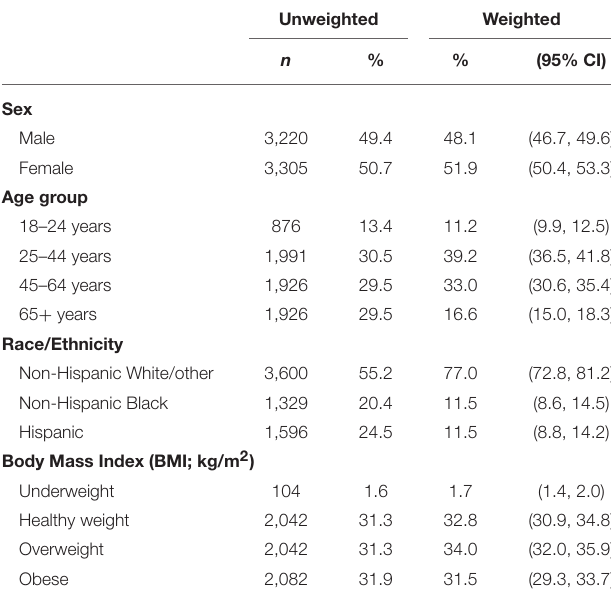
TABLE 1 | Distribution of characteristics among study participants, National Health and Nutrition Examination Survey (NHANES) 2003–2006 ( n = 6,525). Unweighted